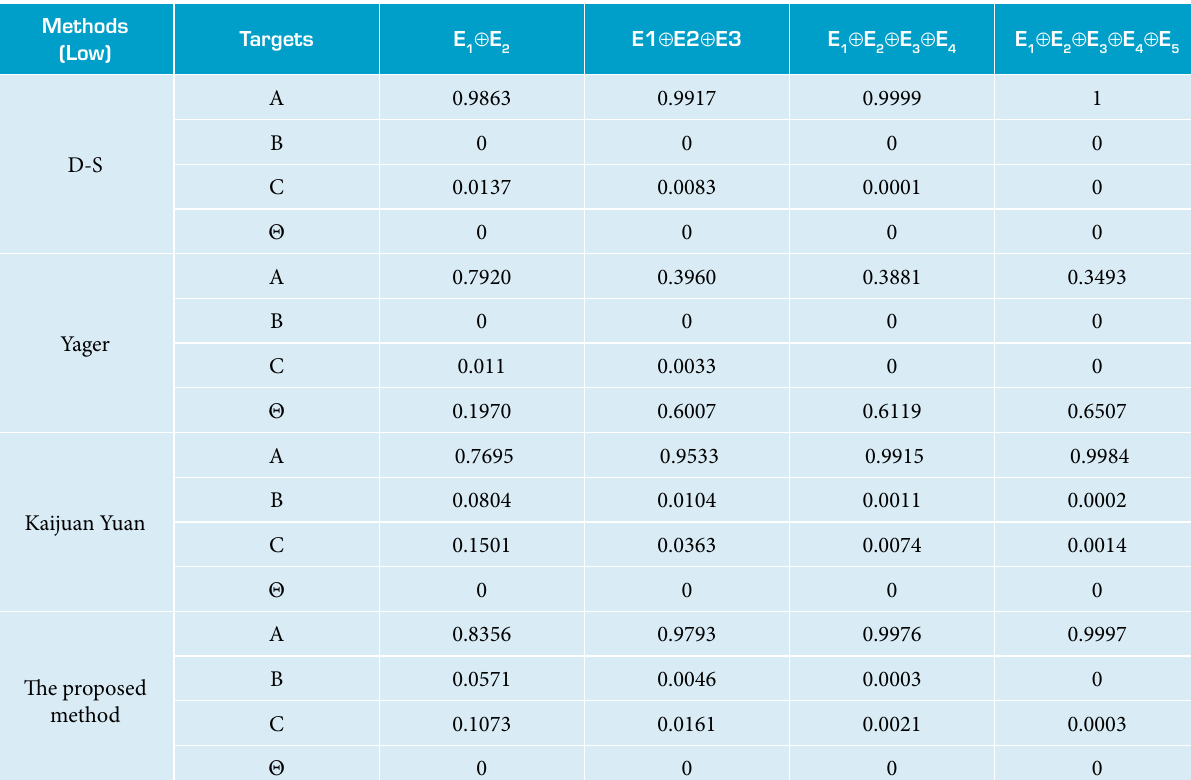
Table 2. Fusion results of different methods with low conflicting